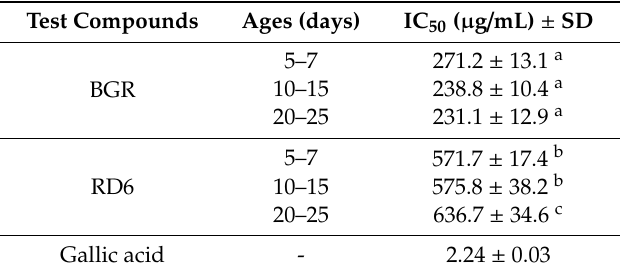
Table 2. 1,1-Diphenyl-2-picrylhydrazyl (DPPH) radical scavenging activity of rice sprout extracts. The half-maximal inhibitory concentration (IC 50 ) is a measurement of the e ff ectiveness of the extract in inhibiting DPPH radical.